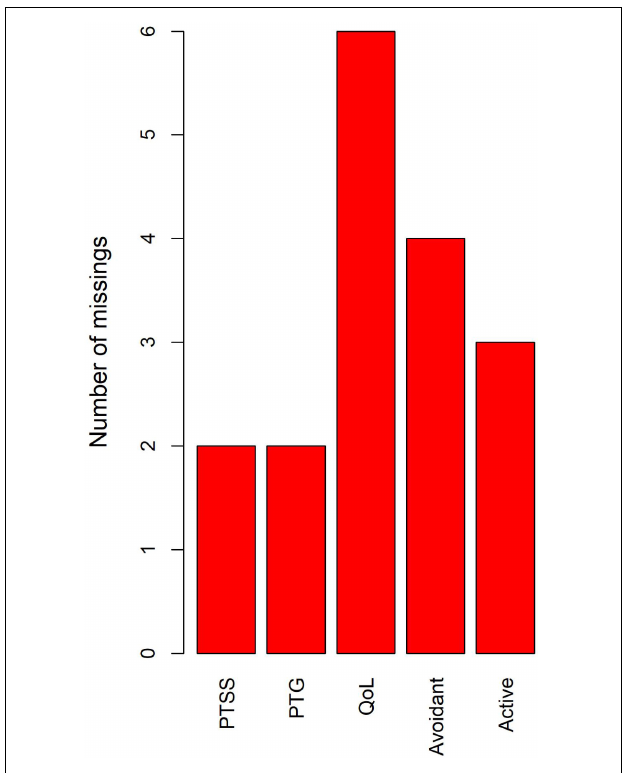
FIGURE 1 | The missing values in the current study. The bar stands for the number of missing values in the corresponding variables, not the number of participants with missing